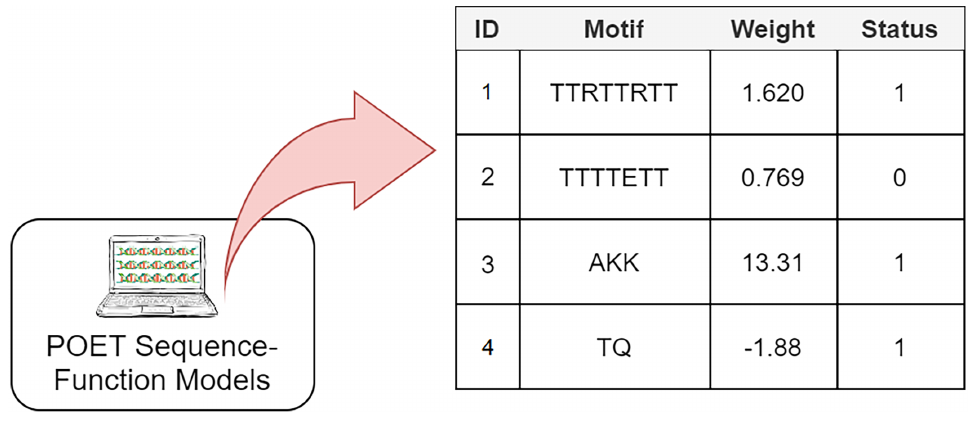
Figure 3 A simple POET model consisting of four example rules with sequences and values obtained from an early POET model. Each symbol in the motif sequence represents one amino acid. Rules 1, 3, and 4 have a status of 1 and are found in dataset. Rule 2 is not found in the dataset and is not expressed for evaluation and prediction purposes. Weights can be negative or positive float